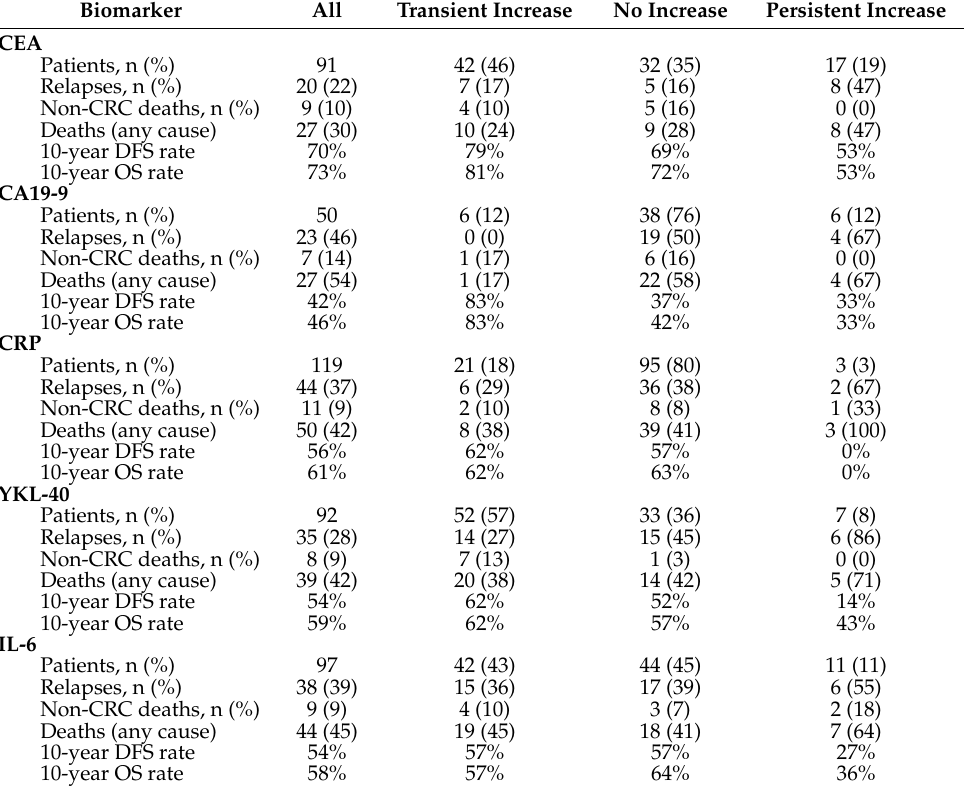
Table 3. 10-year DFS and OS rates in the LIPSYT study according to biomarker dynamics